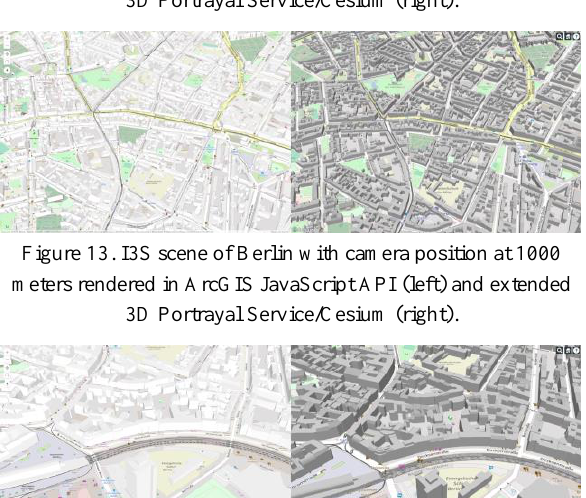
Figure 12. I3S scene of Berlin with camera position at 3000 meters rendered in ArcGIS JavaScript API (left) and extended 3D Portrayal Service/Cesium (right).